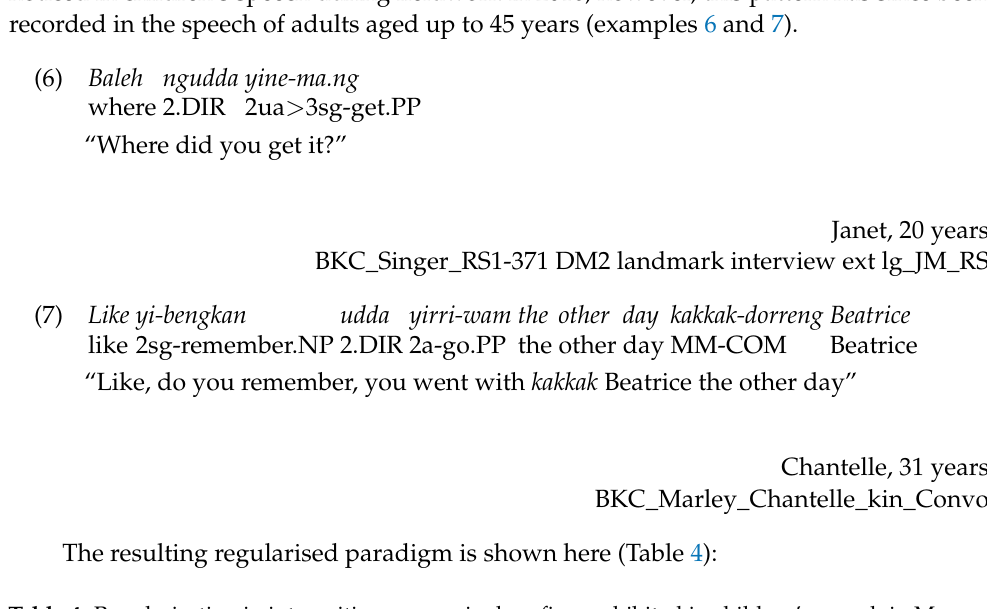
Table 4. Regularisation in intransitive pronominal prefixes exhibited in children’s speech in Mamar- dawerre (in bold). For reference, standard forms are in